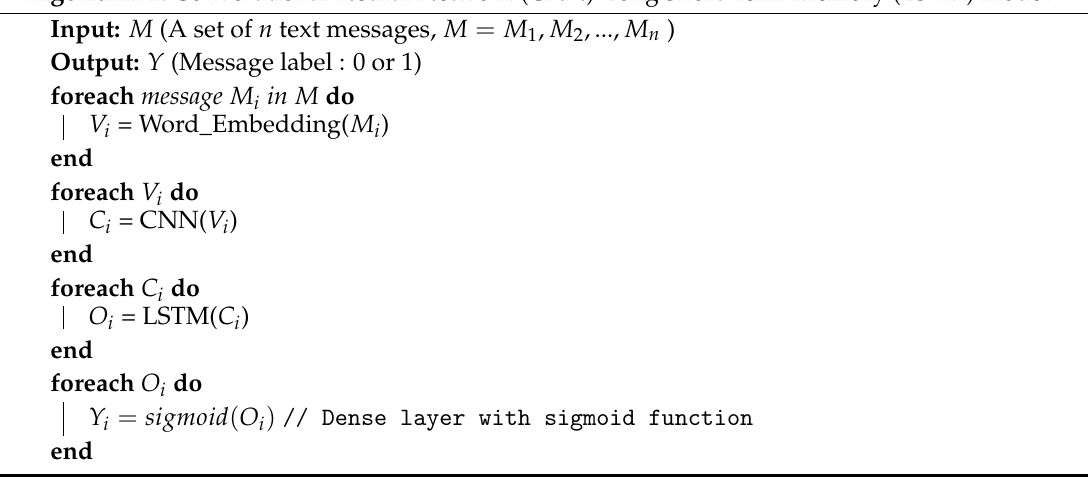
Algorithm 1: Convolutional Neural Network (CNN)-Long Short-Term Memory (LSTM)